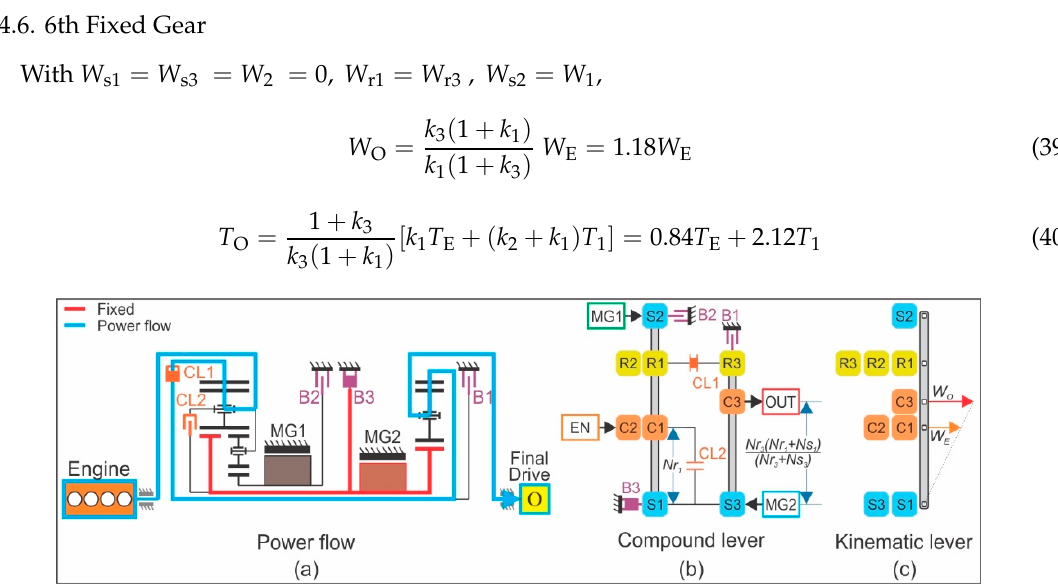
Figure 25. Sixth fixed gear.